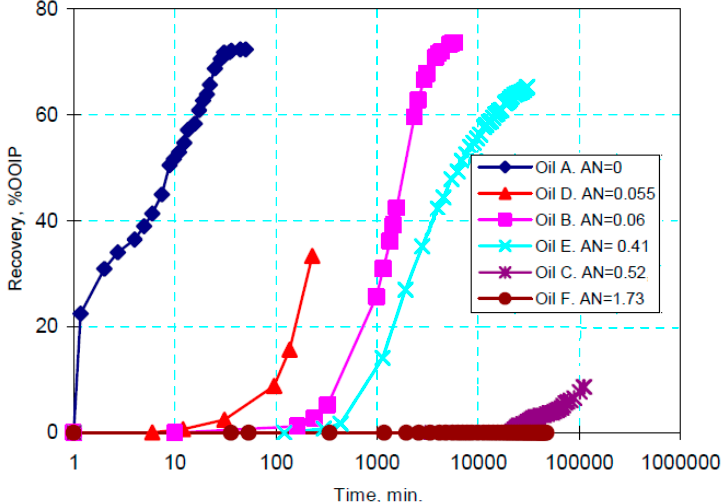
Figure 3. Effect of acid number (AN) on spontaneous imbibition of brine into chalk cores saturated with different crude oil (reproduced from Standnes and Austad [91] with permission).